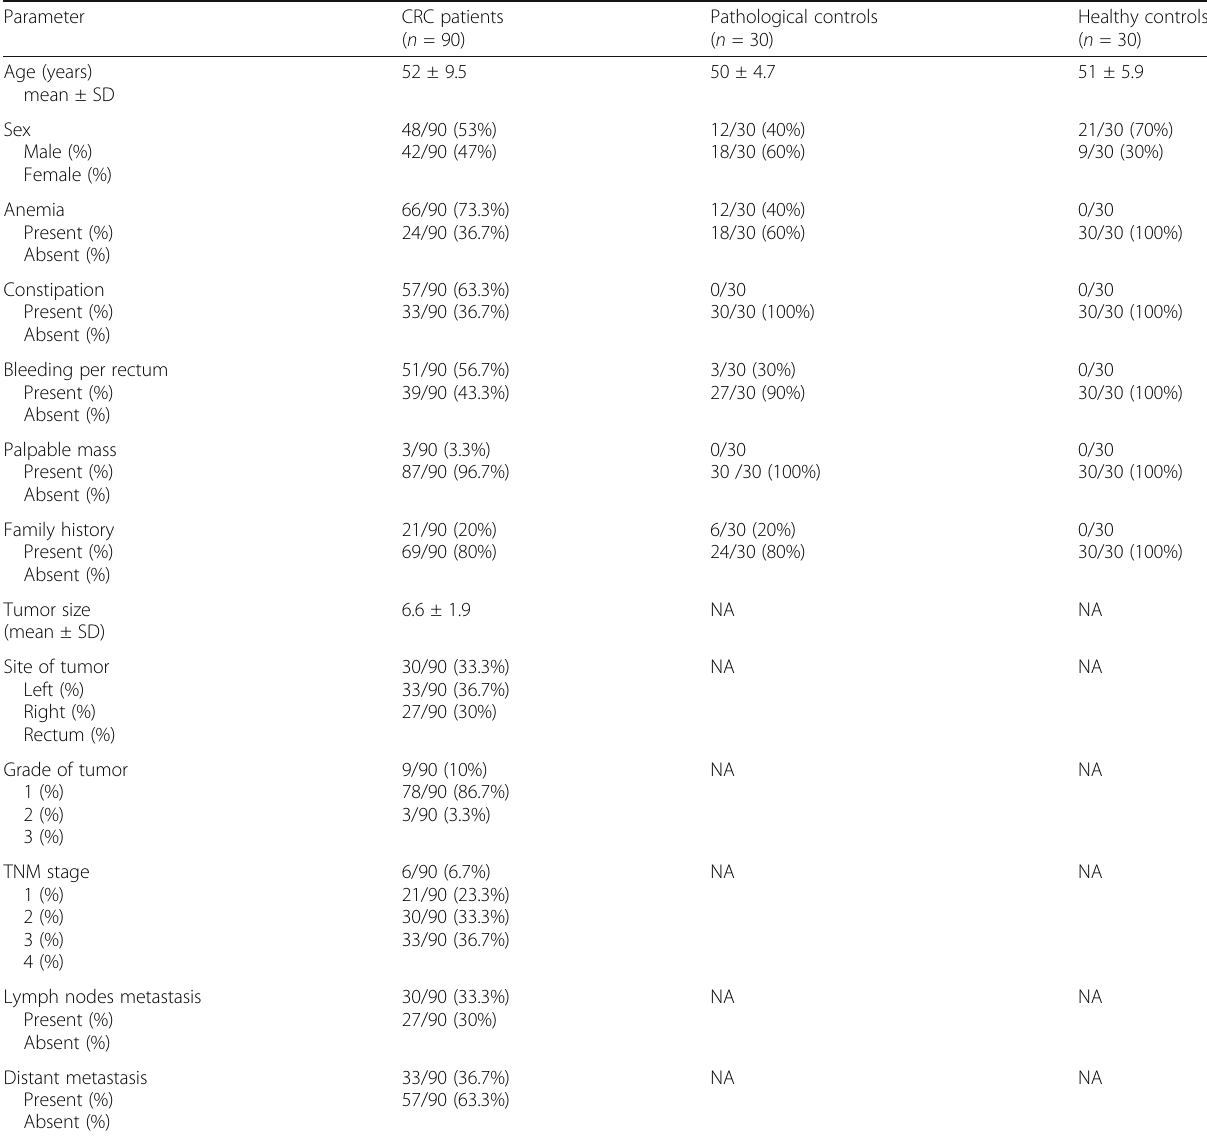
Table 1 Demographic and clinical